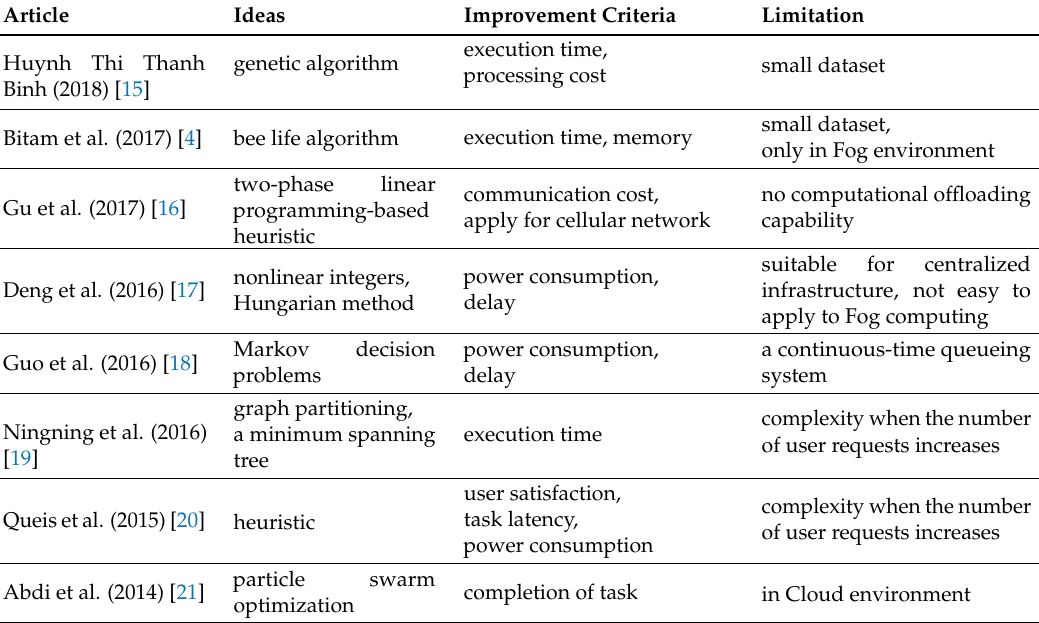
Table 2. Summary of related works about task scheduling algorithms for Fog